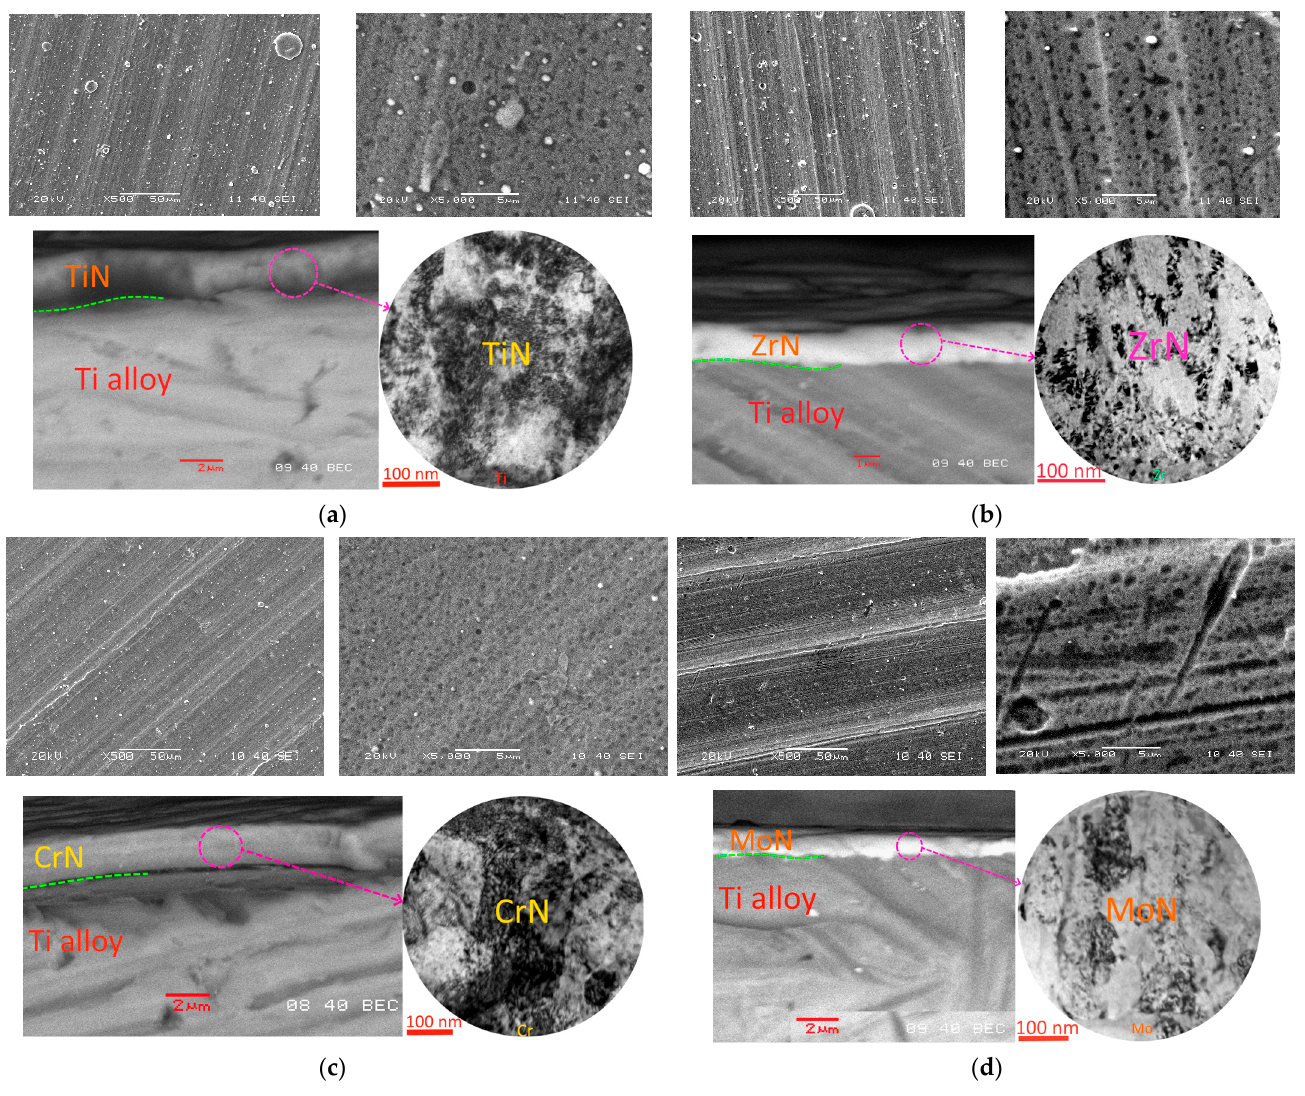
Figure 3. Surface morphology ( top ) and structural features ( right —TEM, left —SEM) ( bottom ) of the samples with the ( a ) Ti-TiN, ( b ) Zr-ZrN, ( c ) Cr-CrN, ( d ) Mo-MoN coatings.